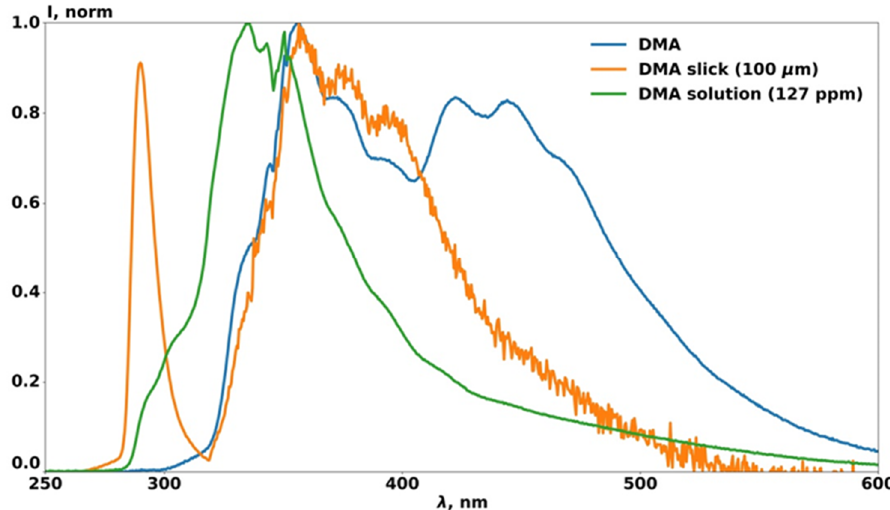
Figure 5. LIF spectra of the light DMA fuel depending on its state.